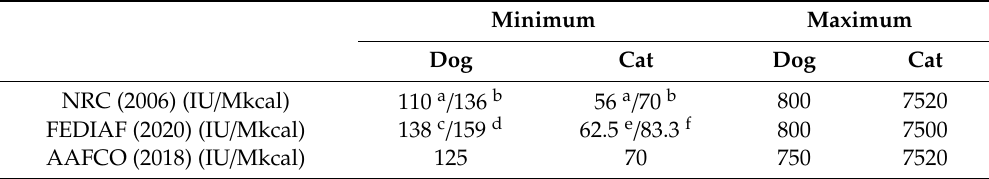
Table 1. Minimum and maximum recommendations of dietary cholecalciferol for adult dogs and cats according to scientific